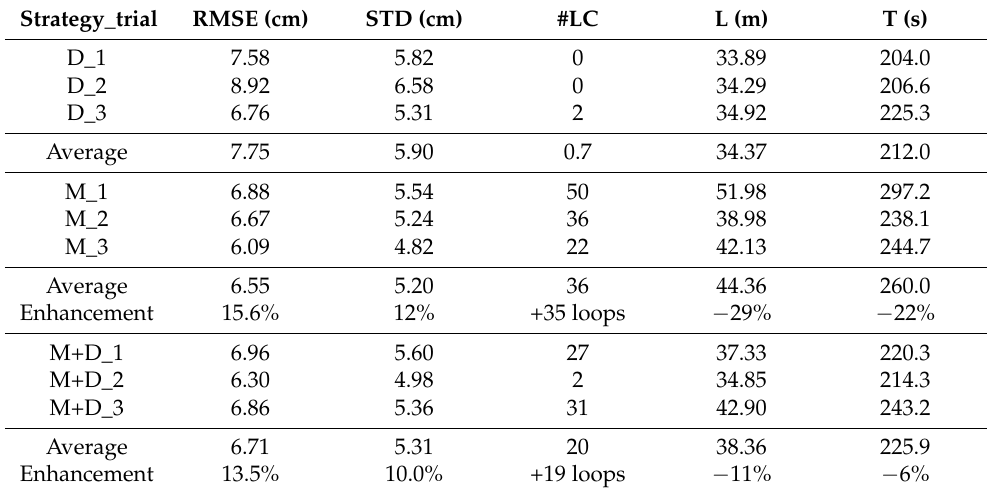
Table 2. Moderate-texture results. PTPD RMSE (cm), PTPD STD (cm), number of loop closures (LCs), exploration path length (L) (m), and exploration time (T) (s).